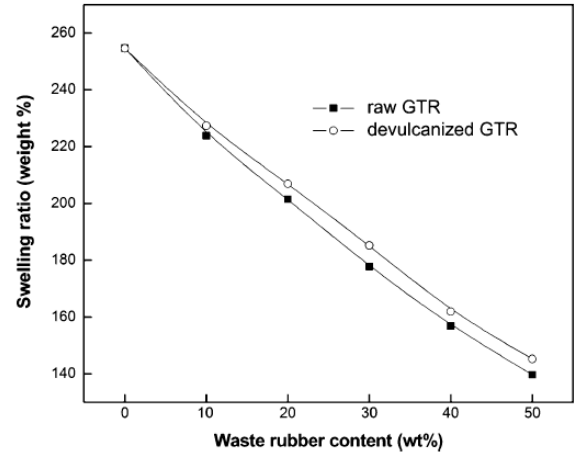
Figure 38. Effect of GTR and RTR content on the swelling ratio of NR compounds soaked in toluene at room temperature for 72 h (reproduced with permission from [124]).